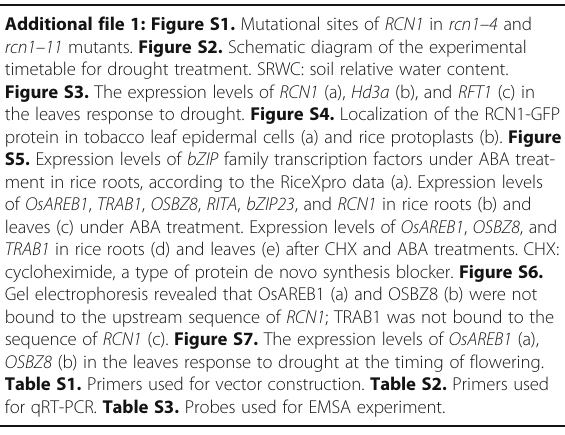
Table S1. Primers used for vector construction. Table S2. Primers used for qRT-PCR. Table S3. Probes used for EMSA